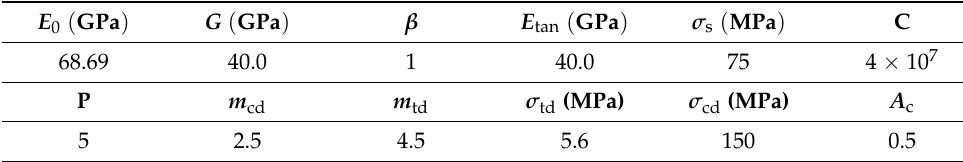
Table 1. Parameters of custom constitutive material.